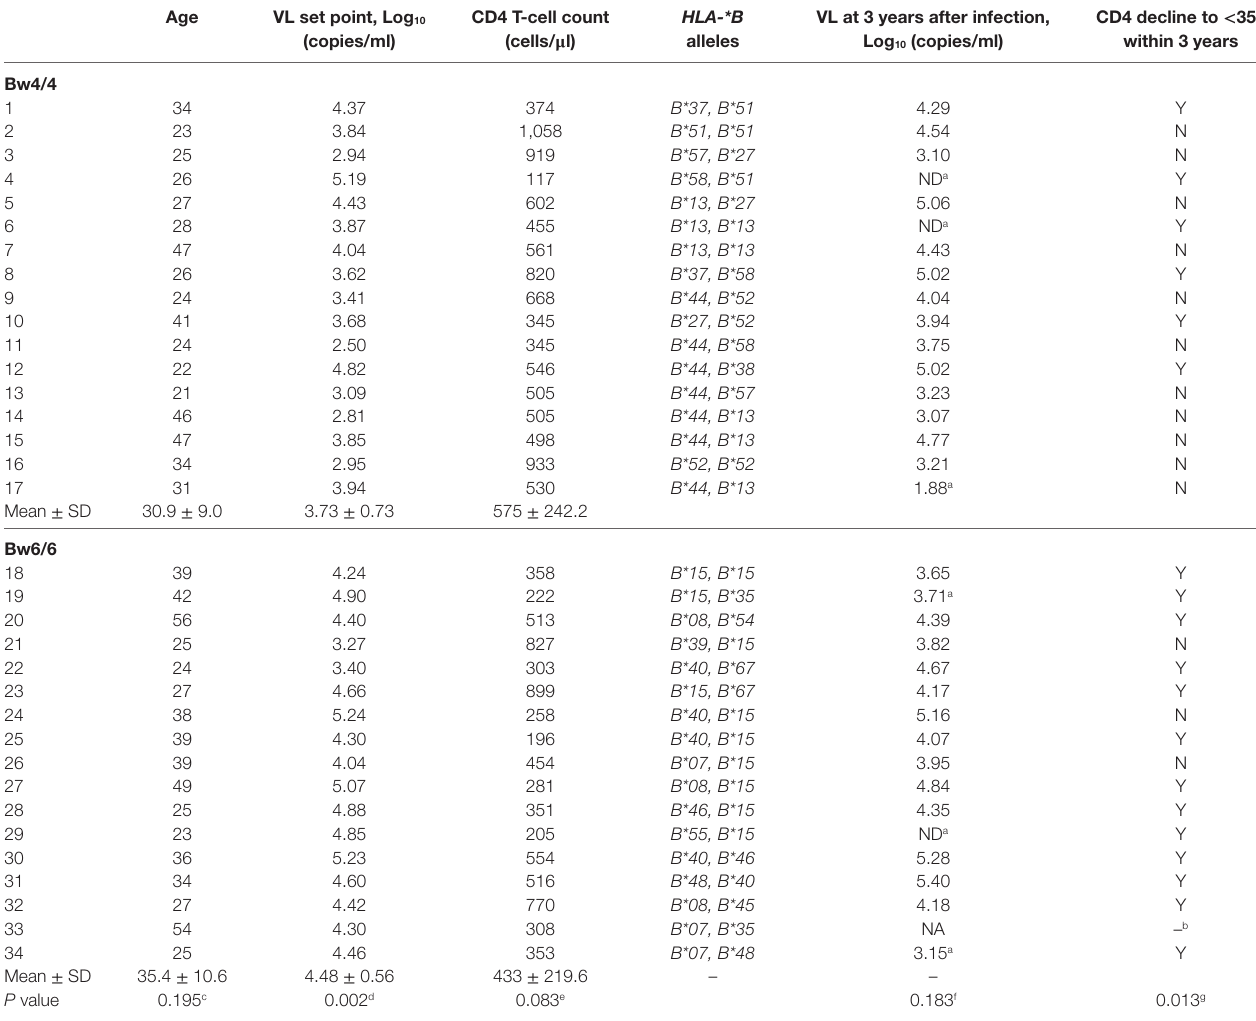
TaBle 1 | Demographics of HIV-1-infected